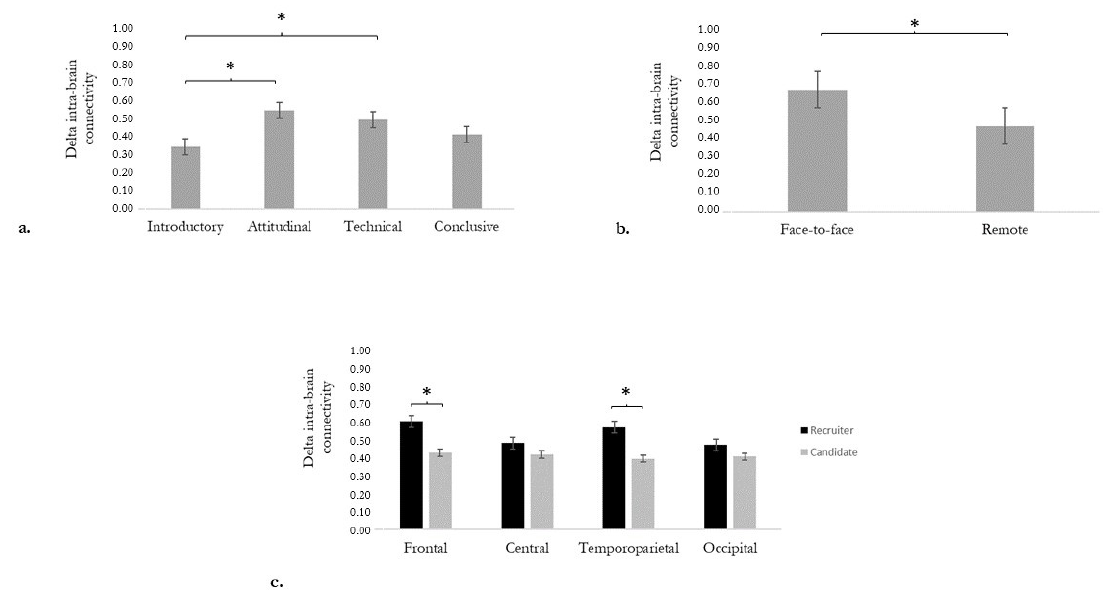
Figure 2. Delta intra-brain connectivity results. ( a ) Bar graph shows differences in Interview. Bars represent ± 1 SE. Stars mark statistically significant pairwise comparisons. ( b ) Bar graph shows differences for Condition. Bars represent ± 1 SE. Stars mark statistically significant pairwise comparisons. ( c ) Bar graph shows differences for Condition*Region of interest (ROI). Bars represent ± 1 SE. Stars mark statistically significant pairwise comparisons.